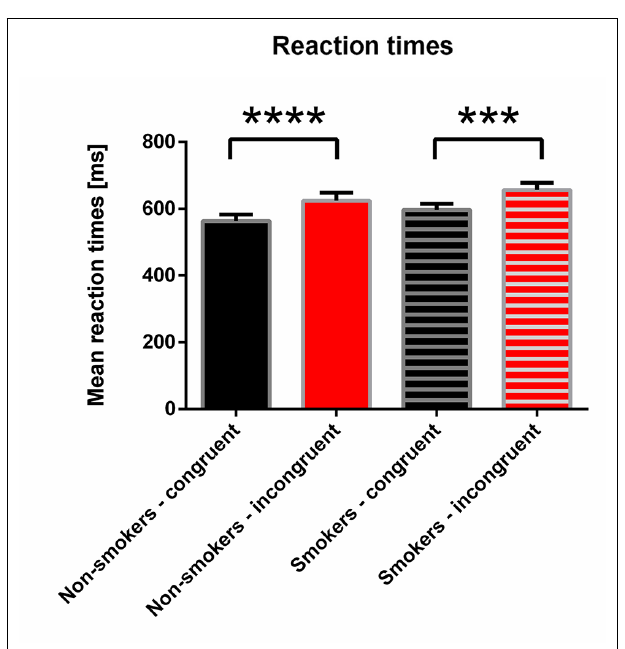
FIGURE 2 | Reaction times for non-smokers and smokers in classifying smoking-related pictures (Go condition). Note that both groups show slower reaction times in the incongruent condition. The difference within the groups is highly significant ( p < 0.0001 and p = 0.0004, for non-smokers and smokers, respectively; paired t -test). *** p < 0.001, **** p <